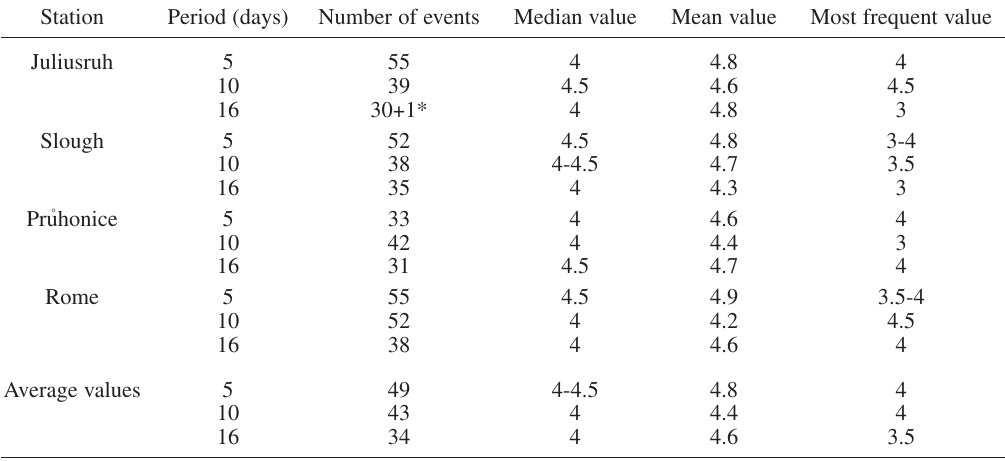
Table VI. Statistics of persistence of planetary wave type oscillations in foF 2 over Europe based on the Mor- let wavelet transform (absolute values). The average values for medians and the most frequent values are pre- sented with a step of 0.5. After Lasˇtovicˇka et al. (2003a).